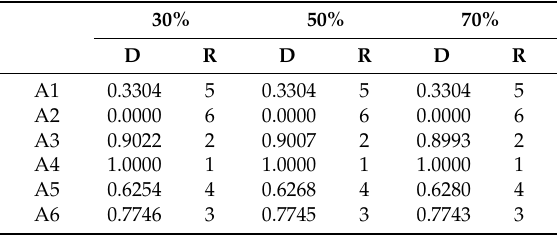
Figure 8. Dominance under different recession coefficients. Table 10. Schemes with different on-grid electricity ranking results.